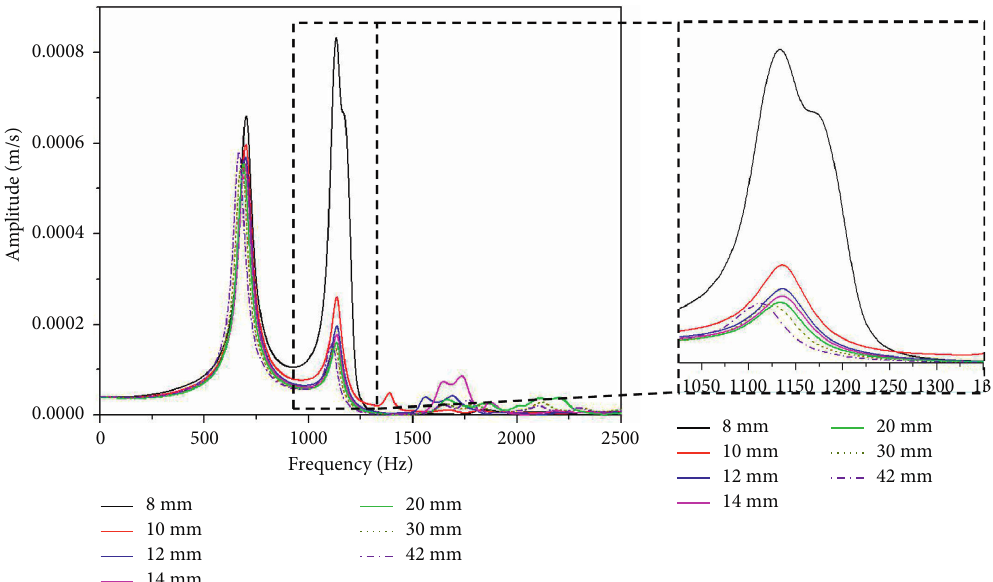
Figure 8: Waveform frequency spectrum of void defect area under different steel plate